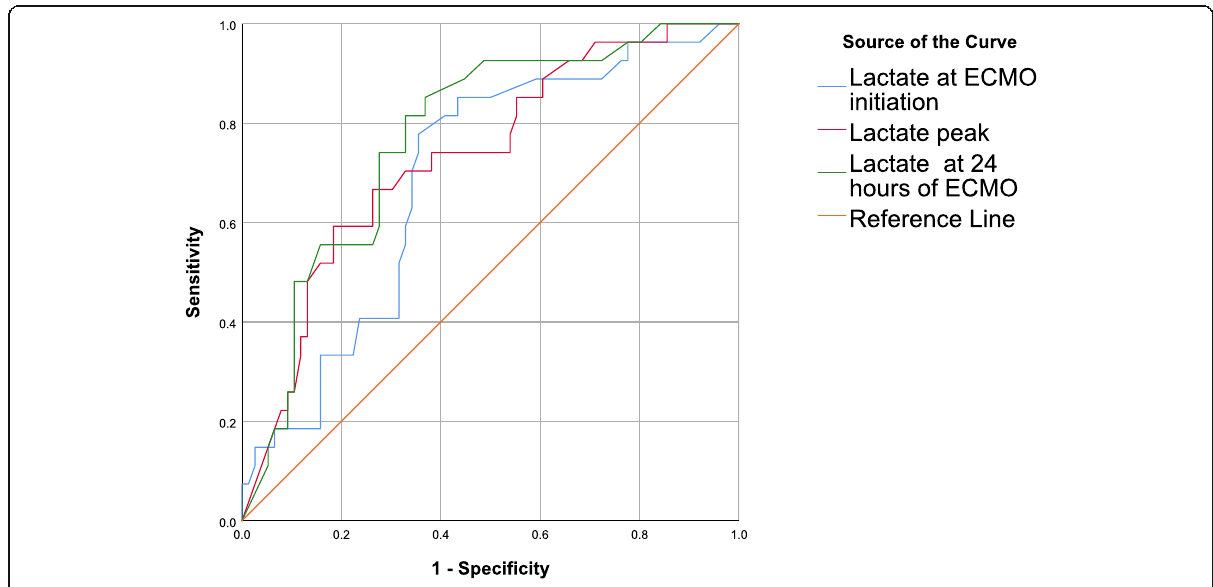
Fig. 3 ROC of blood lactate in differentiating cerebral damage of VA-ECMO-treated